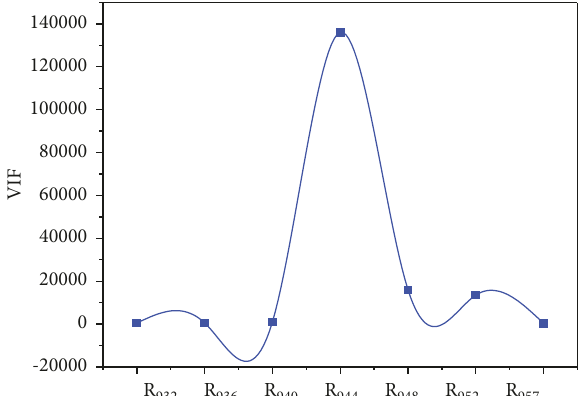
Figure 6: VIF test results of the gray value in the first region of band 4.